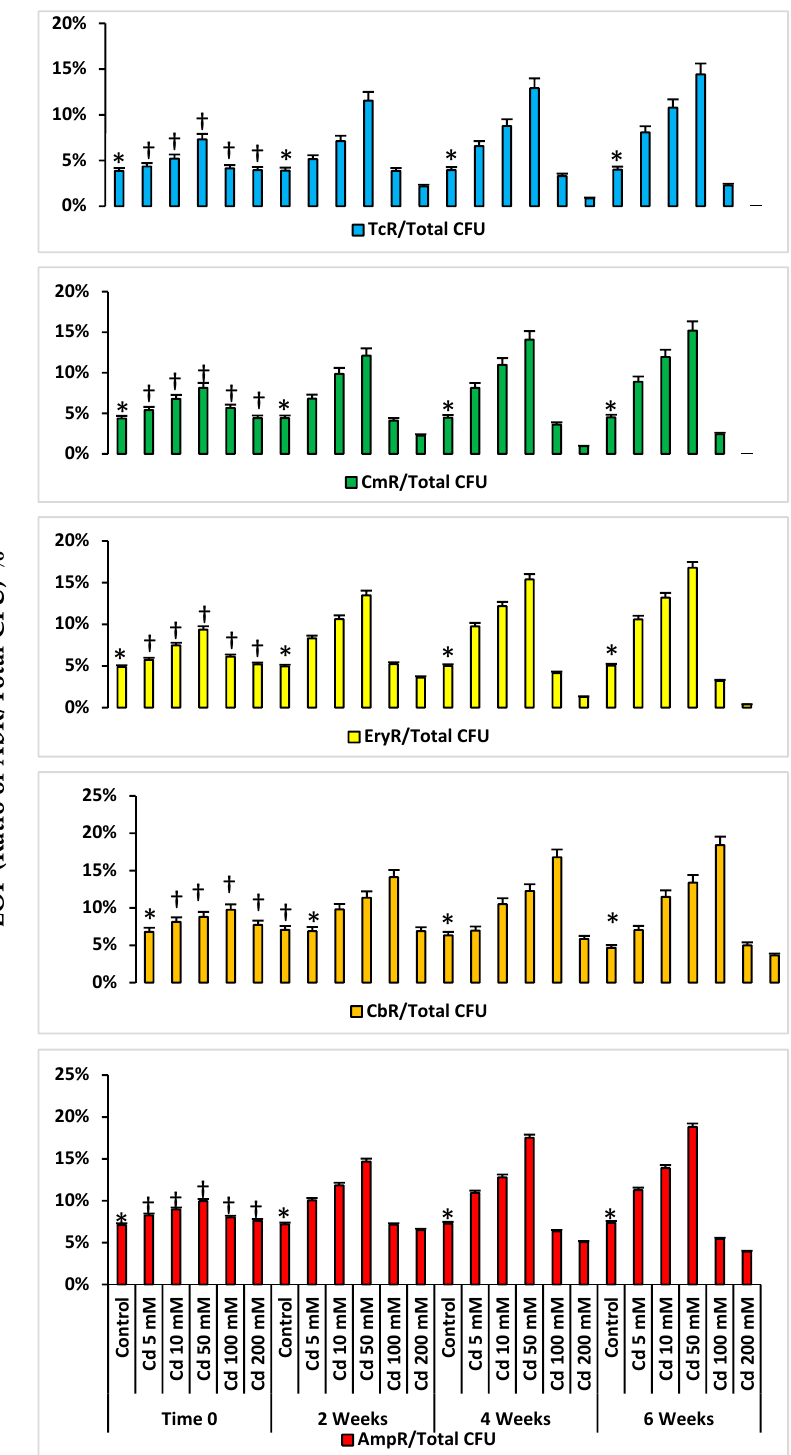
Figure 2. Mean AbR EOPs selected on Abs for Cd-spiked microcosms. * p < 0.05 compared to the AbR EOPs in Cd-spiked microcosms; † p < 0.05 compared to the AbR EOPs in the same Cd-spiked microcosms at 6 weeks.